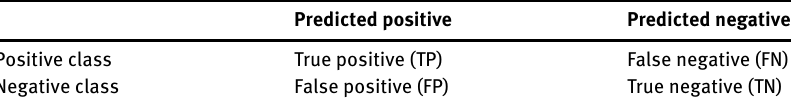
Table 5: Confusion Matrix.